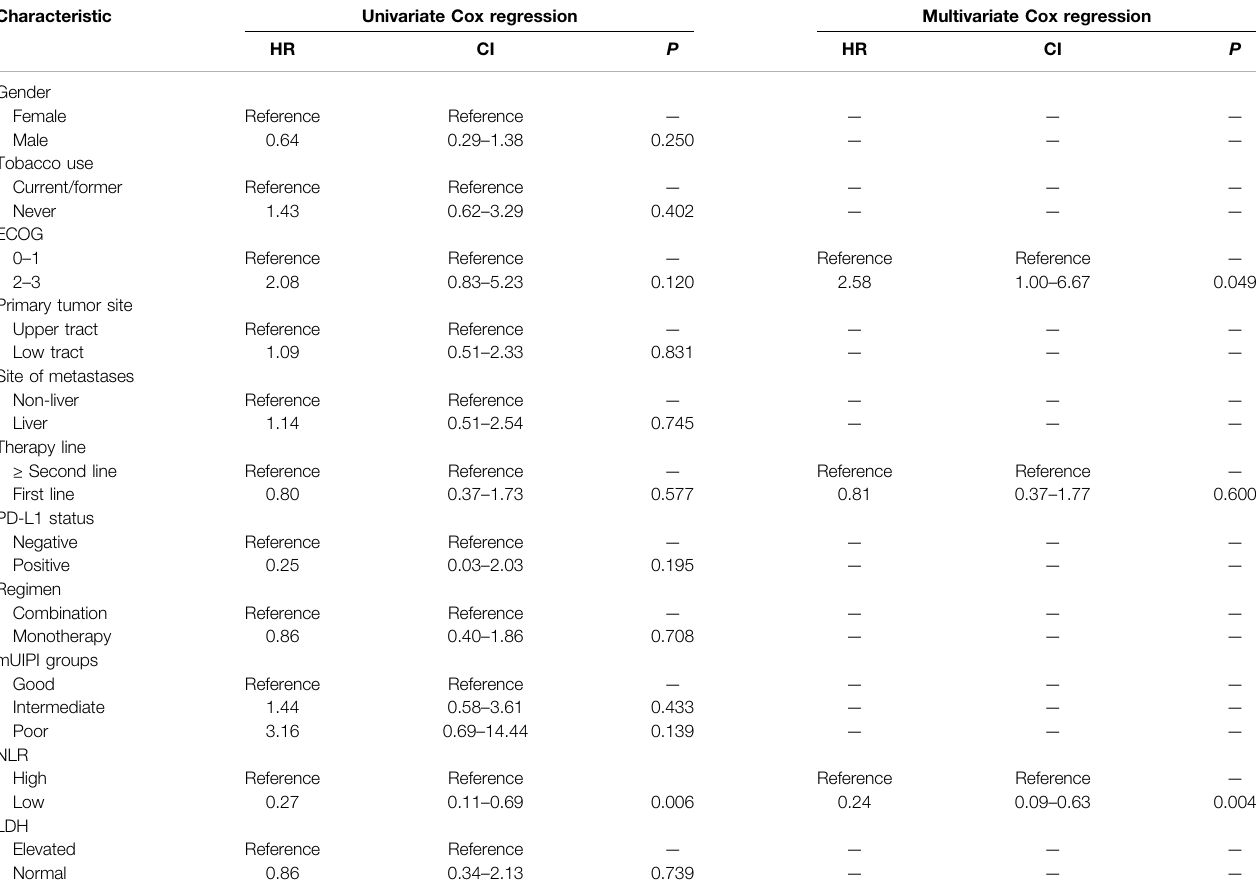
TABLE 5 | Cox proportional hazard regression model of OS on included patients.